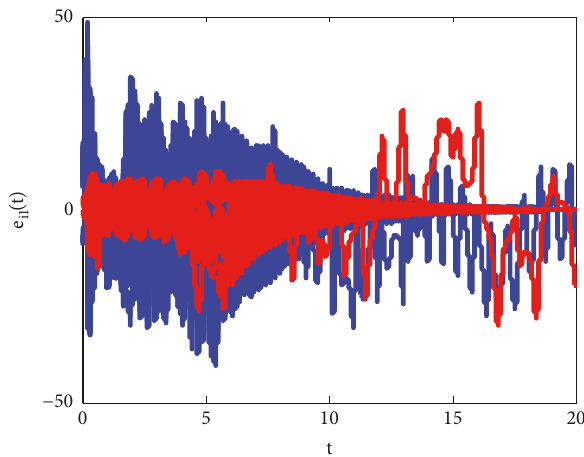
Figure 11: (Color online) More node control community network 𝑒 (𝑡) with 𝑡 . 𝑖1